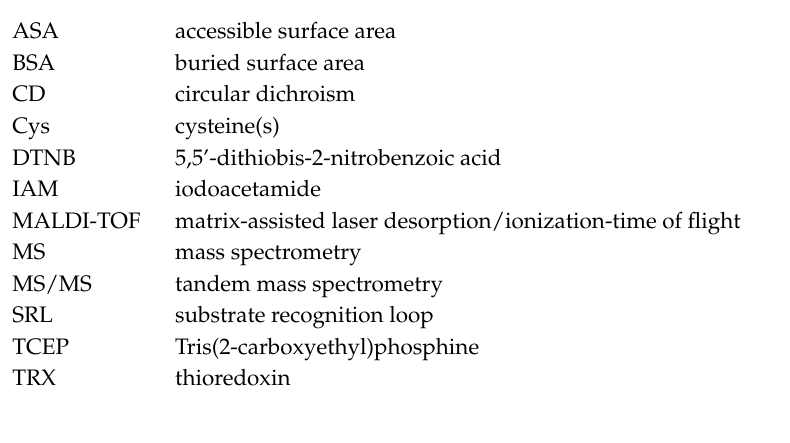
Figure S1: Schematic representation of the Substrate Recognition Loop in AtTRXh1, HvTRXh1, PtTRXh1, PtTRXh4, AtTRXo1, AtTRXo2, and SoTRXm, Figure S2: Far-UV CD spectra of reduced and oxidized CrTRXh1 in Tris-HCl buffer (30 mM; pH 7.9), Figure S3: MALDI-TOF MS analysis of CrTRXh1 after IAM-dependent alkylation, Figure S4: Kinetic of alkylation of CysN and CysC from CrTRXh1, Table S1: Interface interactions including salt bridges and hydrogen bonds in the reduced and oxidized CrTRX h1 (cut-off distance 4.5